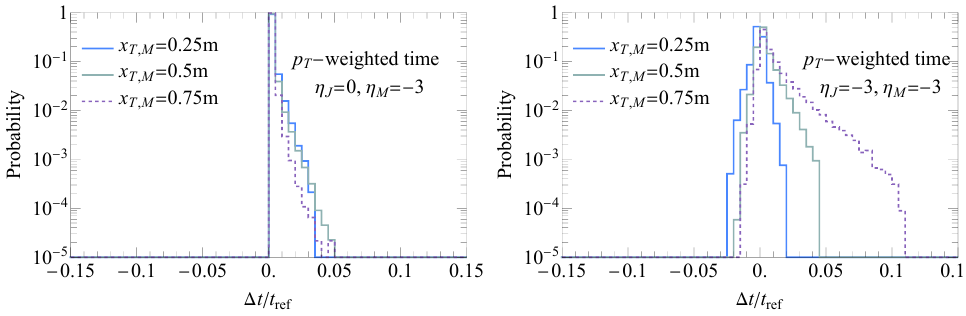
Figure 12 . The relative time difference distribution for the p T -weighted time at x T,M = 0.25 m (blue solid line), 0.5 m (gray solid line), and 0.75 m (purple dashed line) for ( η (left) and ( η ) = ( − 3 , − 3) J , η M